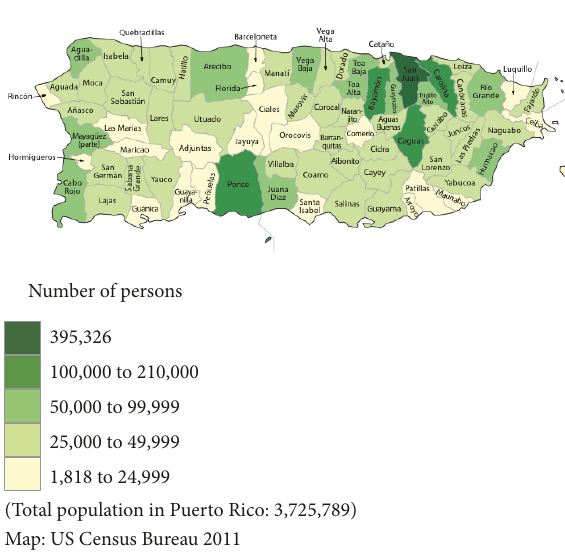
Figure 1: Puerto Rico population per municipality in